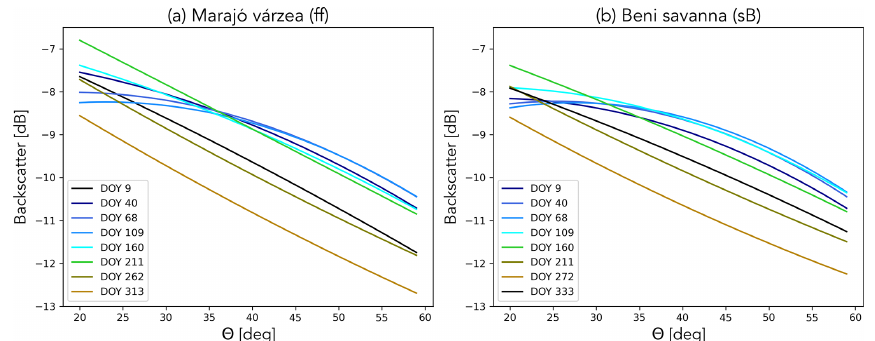
Figure 11. Averaged backscatter as a function of incidence angle for several dates in the Marajó várzea (a) and Beni savanna (b) ecoregions.